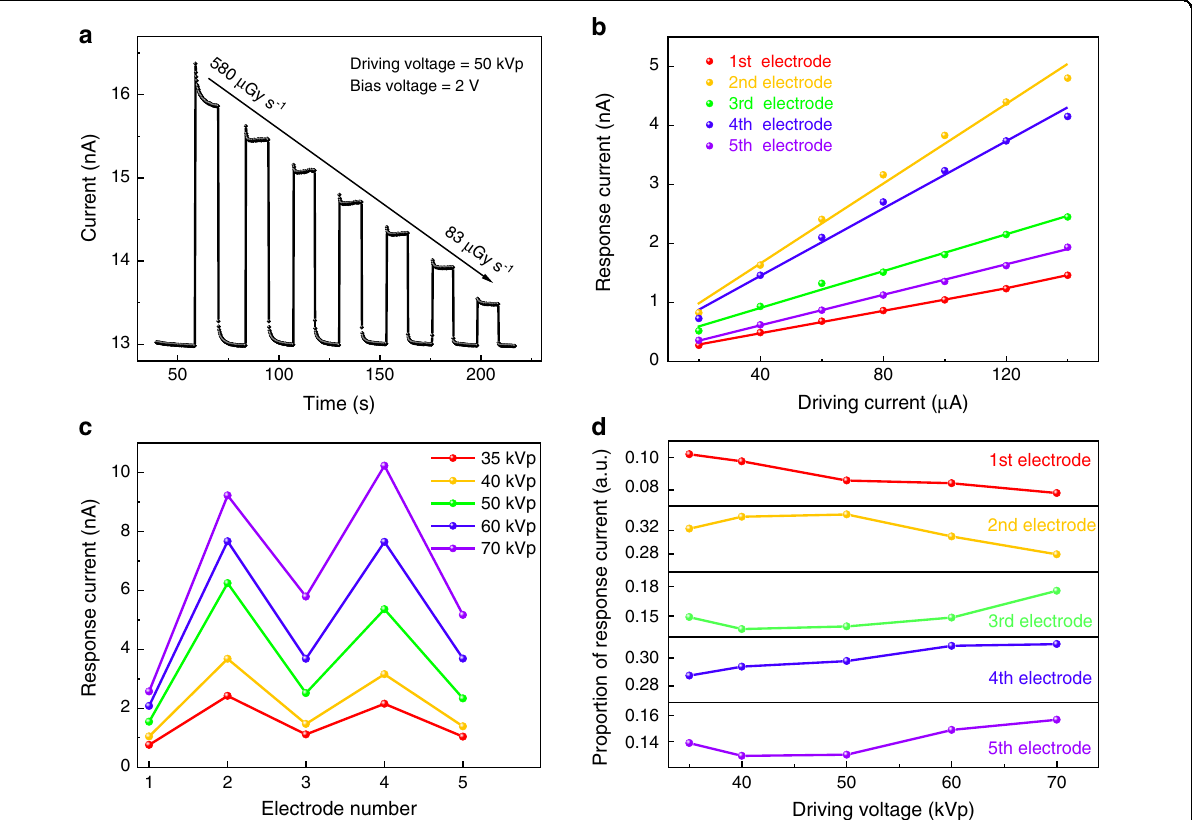
Fig. 3 The X-ray response of the vertical matrix detector. a The current response curve of the 1st electrode toward different X-ray dose rates. b The linear response of the fi ve pairs of electrodes. c The response current of the fi ve pairs of electrodes under continuous multi-energy X-ray spectra with different driving voltages. d The proportion of the response current of each electrode under different driving